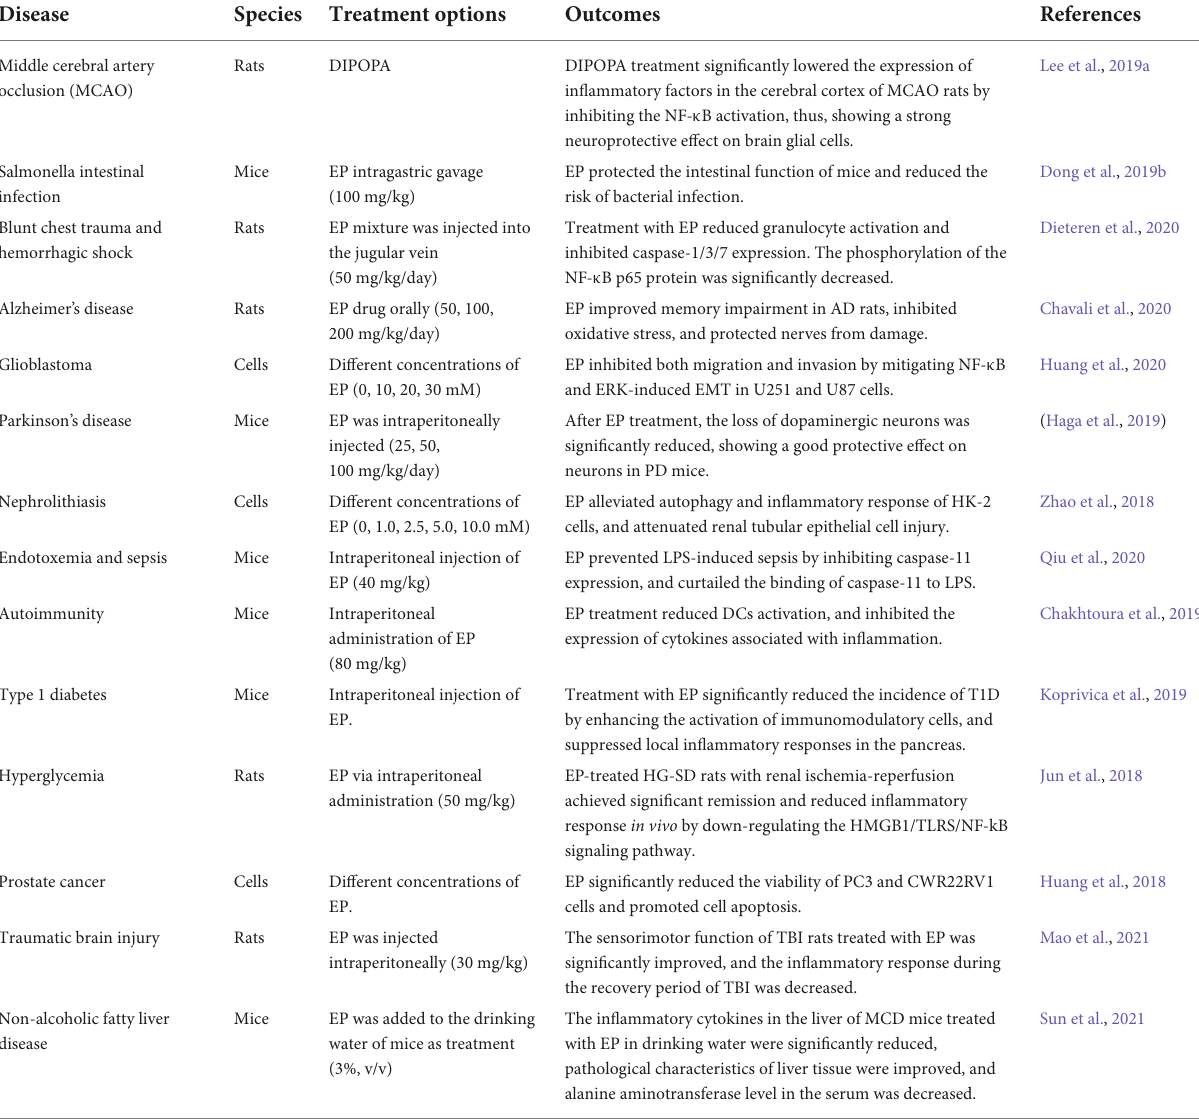
TABLE 1 The application of EP in various